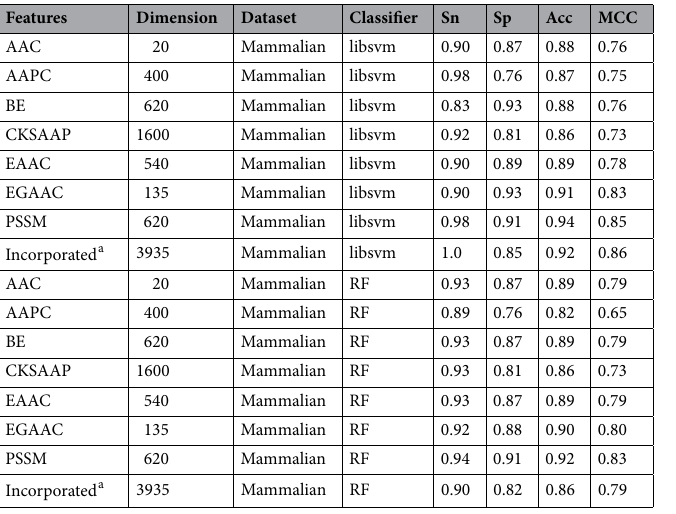
a Stands for the combination of each single feature, which